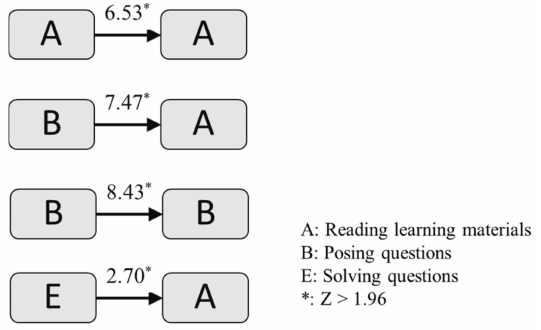
Figure 7. The simple behavioral transitional patterns.